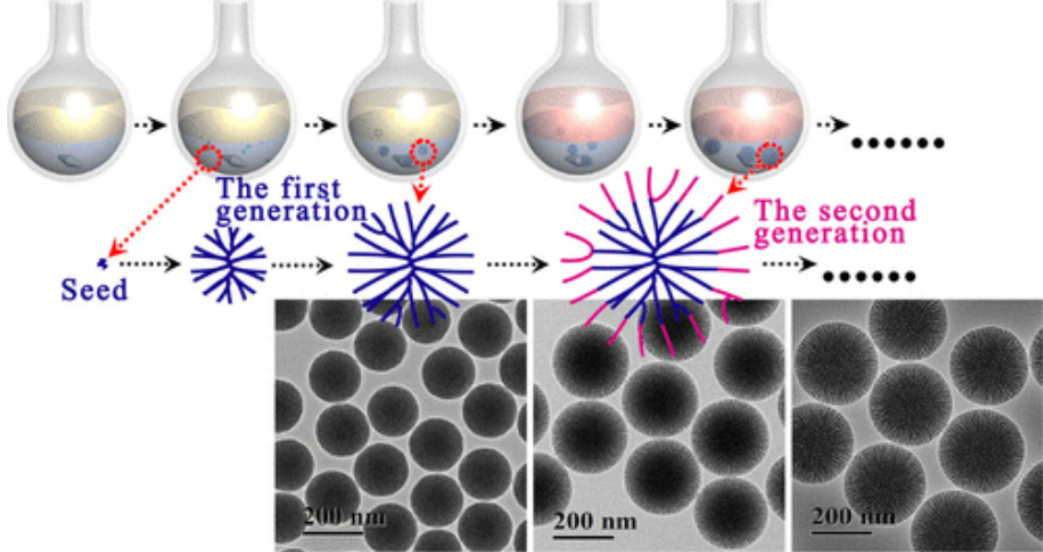
Figure 1. Synthesis process, mechanism of interfacial growth, and representative micrographs of the dendritic mesoporous silica nanospheres. Reproduced with permission from Ref. [57], Copyright 2014, American Chemical Society.